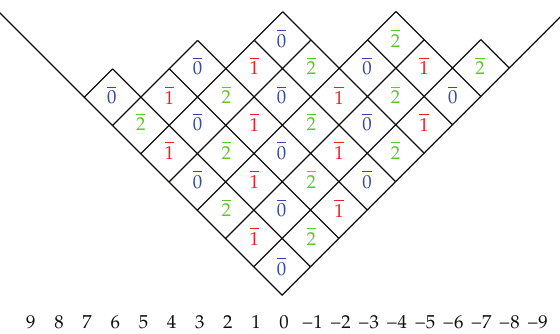
Figure 1: The partition (cid:3) 7 , 6 , 6 , 5 , 5 , 3 , 3 , 1 (cid:4) with each box containing its color for (cid:2) (cid:7) 3. The content c (cid:3) b (cid:4) of a box b is the horizontal position of b reading right to left. The contents of boxes are listed beneath the diagram so that c (cid:3) b (cid:4) is aligned with all boxes b of that